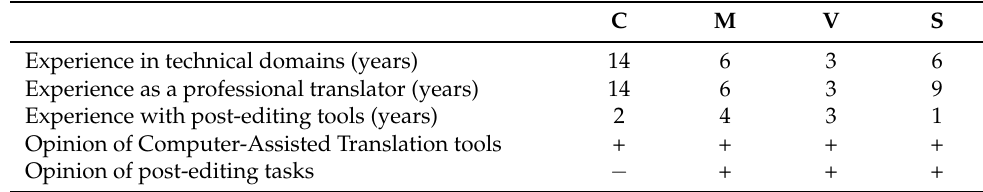
Table 4. Translator Details Summarised.